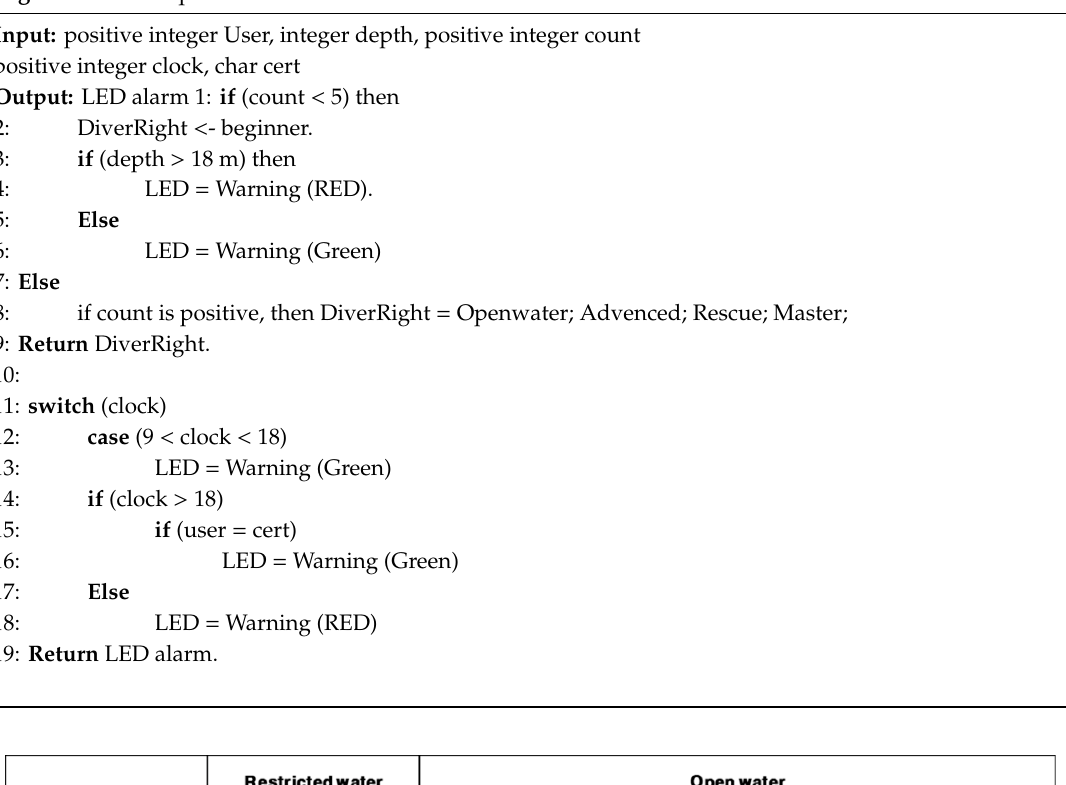
Algorithm 2 dive qualification method